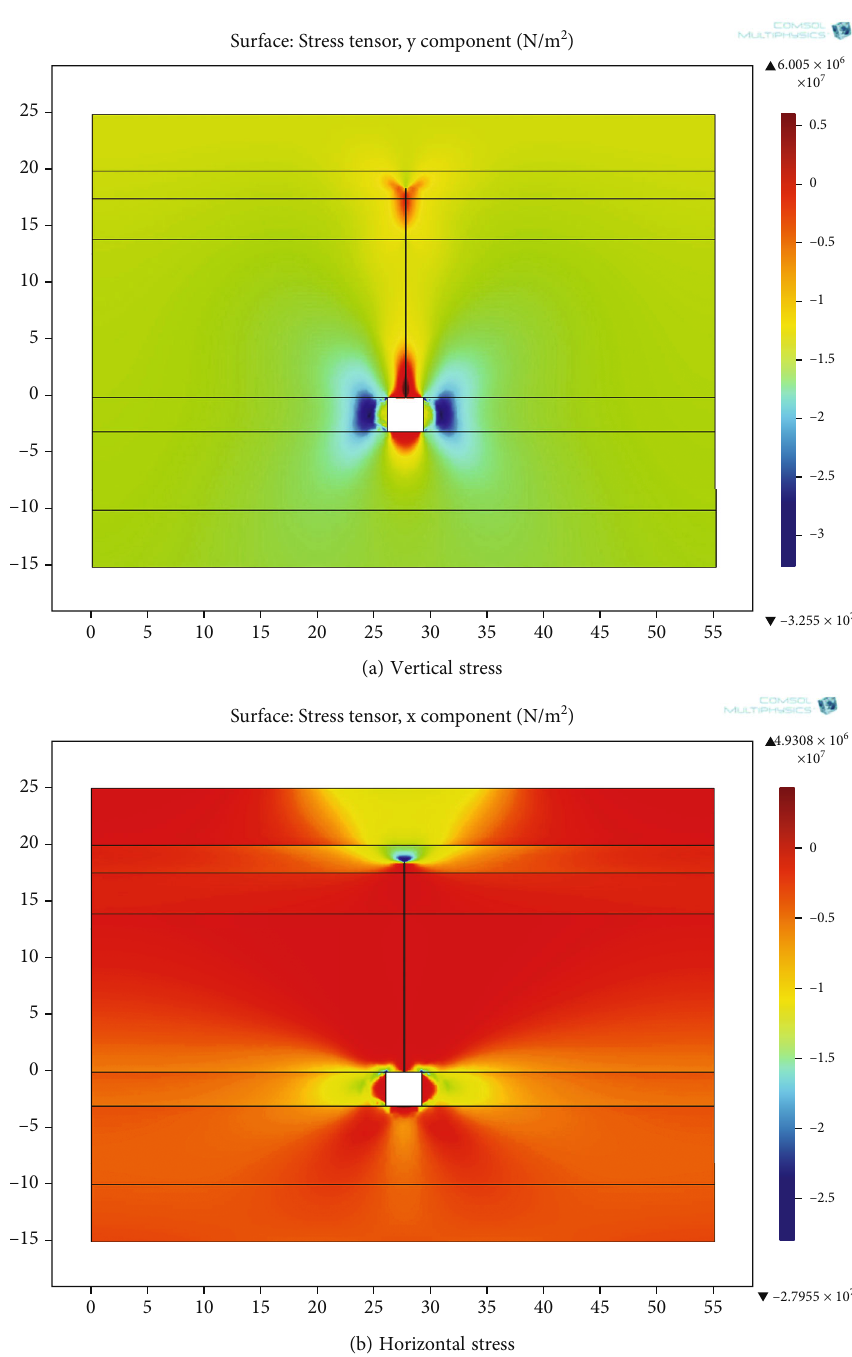
Figure 7: Stress distribution of surrounding rock after the roadway and borehole